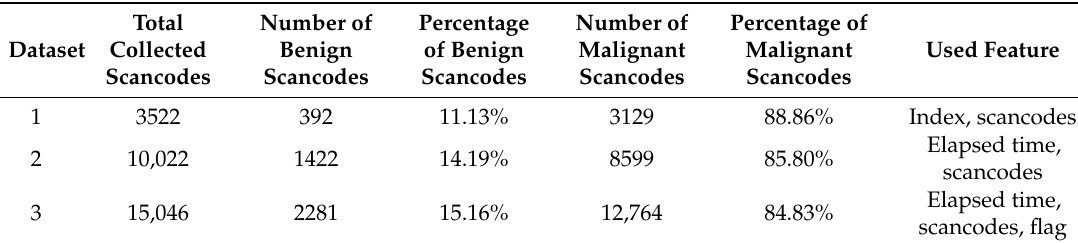
Table 3. Whole collected data and dataset